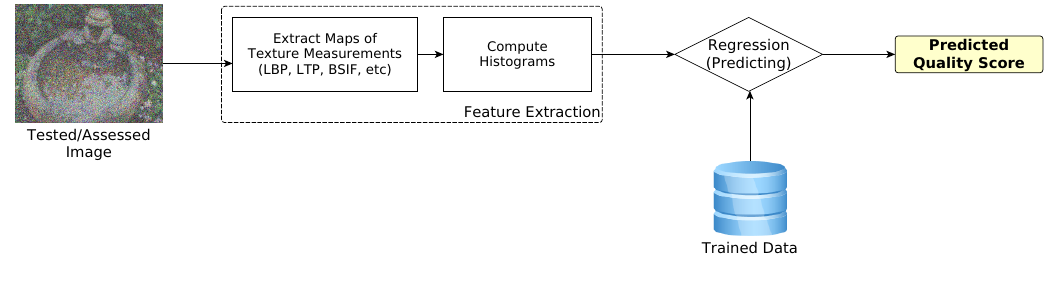
Figure 24. Predicting quality